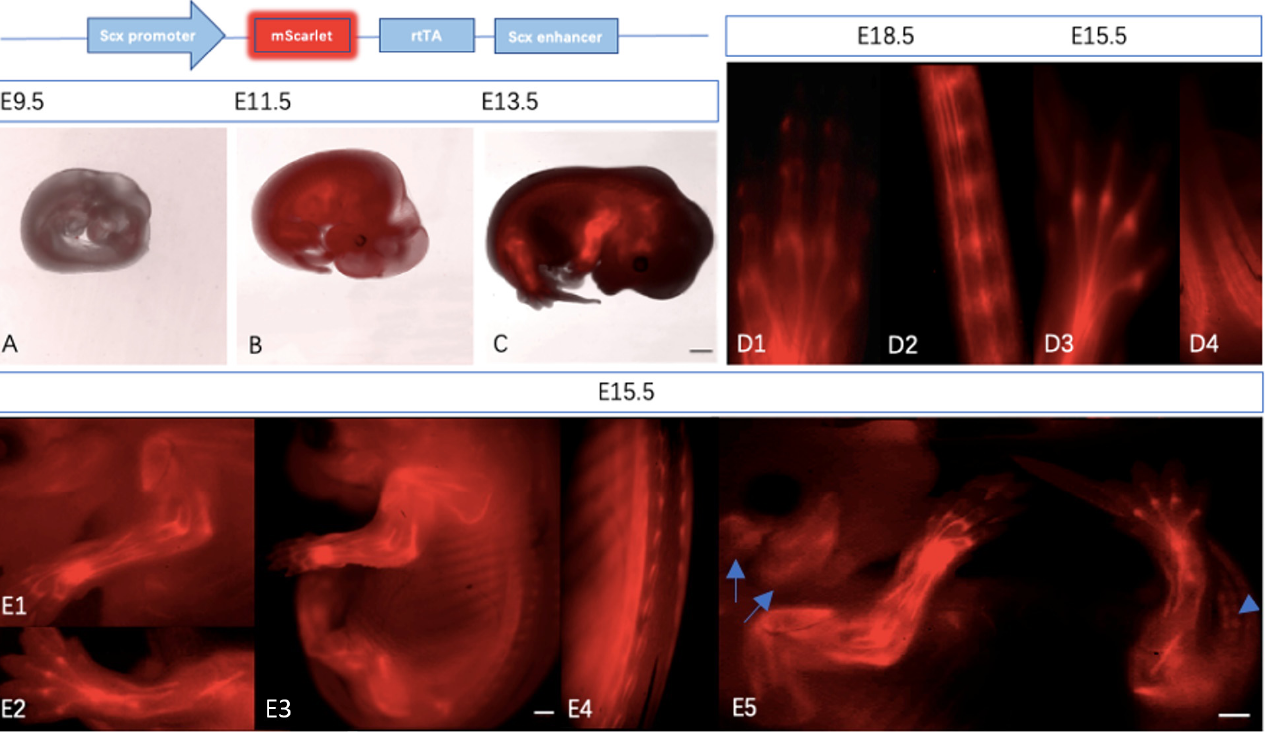
Figure 2. Areas of Scx -mScarlet expression coincided with tendon atlas. To characterize Scx -mScarlet transgenic mice, we detected the red signal of the whole-mount embryos using the binocular fluorescence microscope. The schematic illustration above indicates the Scx -mScarlet transgene construct. A , B , C : Scx -mScarlet embryo at E9.5, E11.5, and E13.5, respectively. D1 : Scx -mScarlet in a skinned hind paw of E18.5 embryo. D2 : Scx -mScarlet in a skinned tail of E18.5 embryo. D3 : Scx -mScarlet in the hind paw of E15.5 embryo. D4 : Scx -mScarlet in the tail of E15.5 embryo. E1 : Scx -mScarlet in a forelimb of E15.5 embryo. E2 : Scx -mScarlet in a hindlimb of E15.5 embryo. E3 : Lateral views of the Scx -mScarlet embryo at E15.5. E4 : Scx -mScarlet in the ribs of E15.5 embryo. E5 : Live whole-mount images of an Scx -mScarlet embryo at E15.5 (Scale bar = 500 μ m in C , E3 , E5 ; arrows show tendons around the developing ipsilateral temporalis and masseter muscles; arrowhead indicates the mScarlet-expression in the annulus fibrosus.)